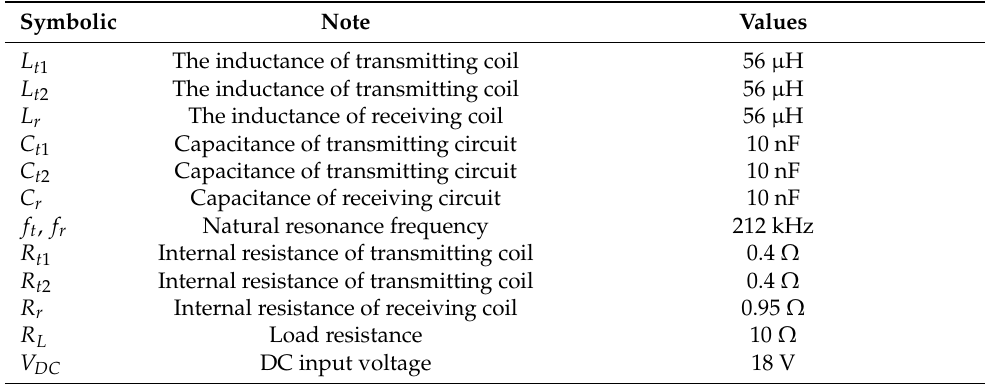
Table 2. DTC-WPT experimental parameters.